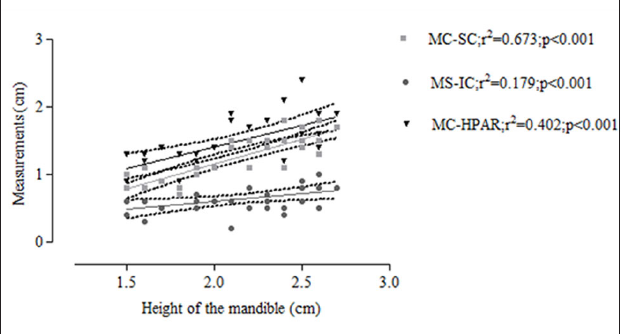
Fig. 6. Association between the height of the mandible and the measurements of the distance from the mandibular canal to superior cortical (MC-SC), the distance from the mandibular canal to inferior cortical (MC-IC), and the distance from the mandibular canal to the higher point of the alveolar ridge (MC-HPAR). The distance of the highest point on the alveolar ridge is directly correlated with the superior height (r 2 =0.897; p<0.05) and the lingual weight (r 2 =0.537; p<0.05). A